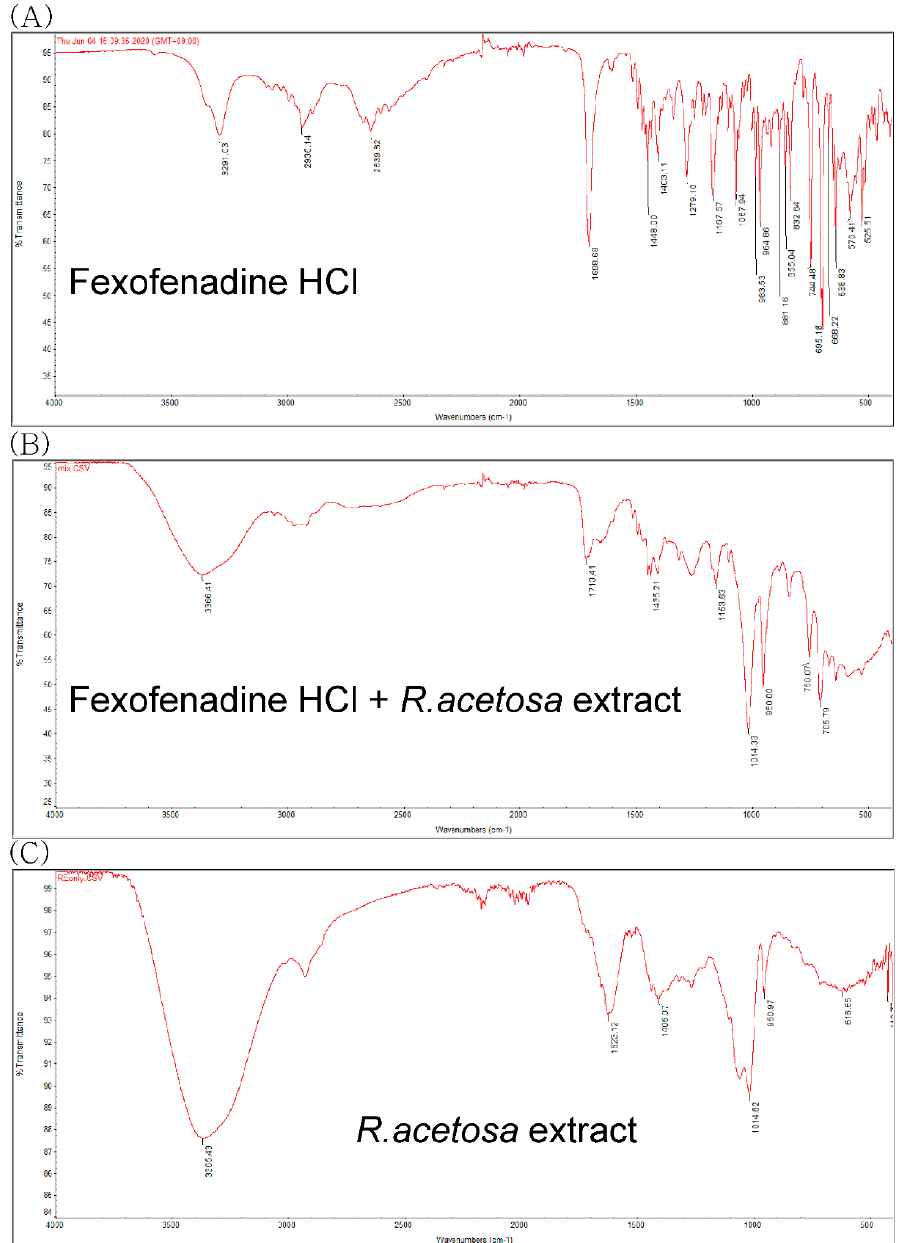
Figure 6. FT-IR spectra of ( A ) fexofenadine, ( B ) a mixture of fexofenadine and R. acetosa extract and ( C ) R. acetosa extract.